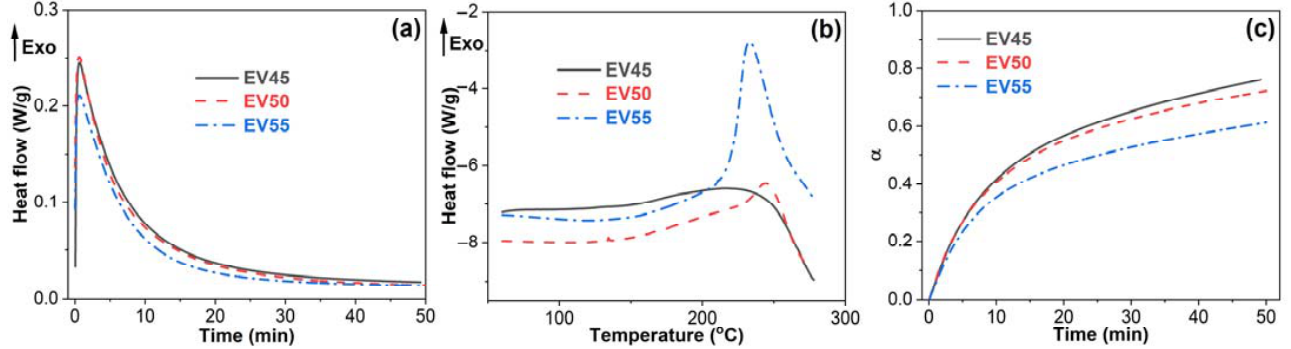
Figure 3. ( a ) Isothermal curing at 120 °C, ( b ) dynamic curing and ( c ) extent of reaction as a function of time at 120 °C of the original epoxy vitrimers.